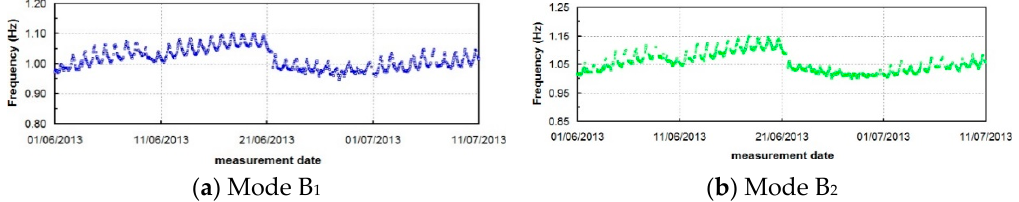
Figure 11. Gabbia Tower in Mantua. Zoom of the natural frequency of modes B1 ( a ) and B2 ( b ) in the period between 01/06/2013 and 10/07/2013. The frequency shifts down highlight the effects of the Garfagnana earthquake [19].